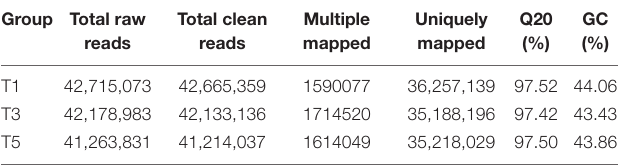
TABLE 4 | Summary statistics of RNA sequencing